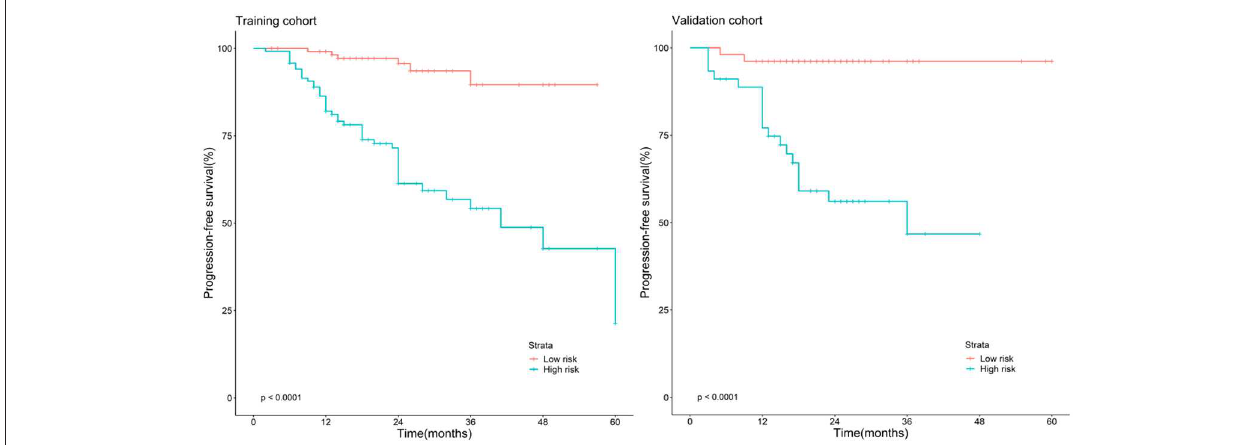
FIGURE 3 | Stratified analyses were performed to estimate progression-free survival in the training cohort and validation cohort; high-risk patients show lower progression-free survival rate than low-risk patients, P <